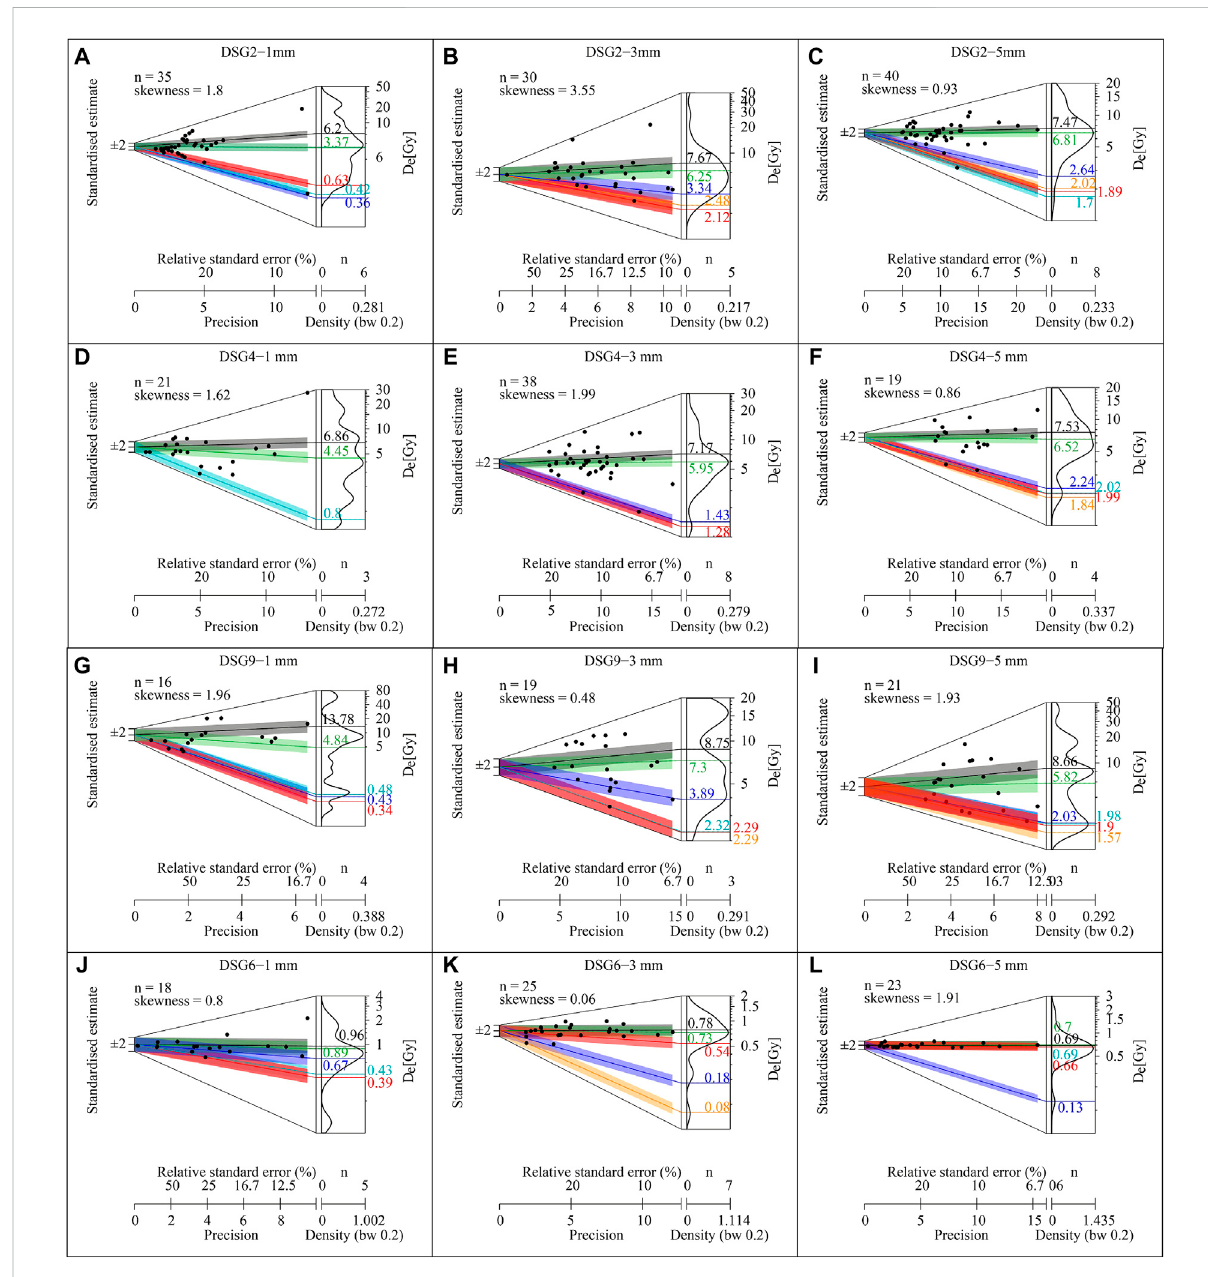
FIGURE 5 Abanico plots of natural dose distributions of DSG2with 1-, 3-, 5-mm aliquots (A – C) ;DSG4 with 1-,3-, 5-mm aliquots (D – F) ;DSG9 with 1-,3-, 5-mm aliquots (G – I) and DSG6 with 1-, 3-, 5-mm aliquots (J – L)